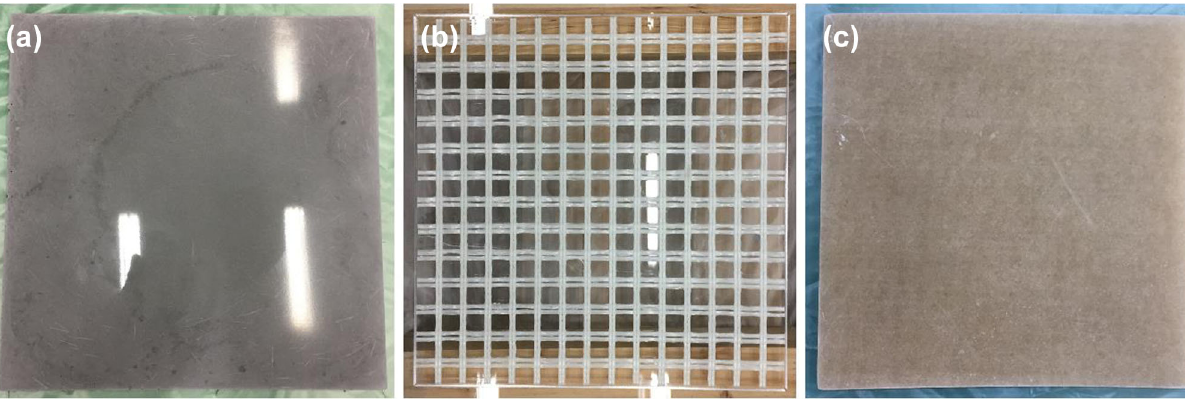
Fig. 6 Face sheets applied to the composite sandwich panels; a UHPFRC plate, b GFRP mesh (before pouring UHPC in a formwork), and c GFRP